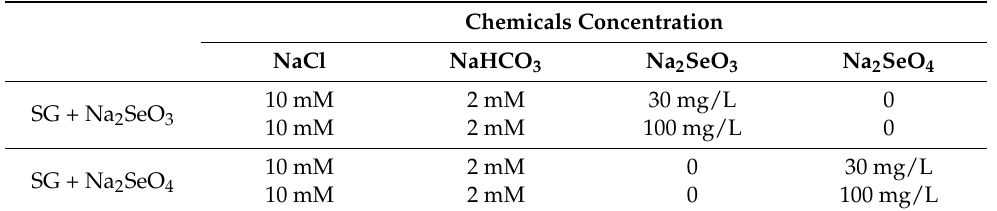
Table 3. Chemical composition of the solution for the immersion